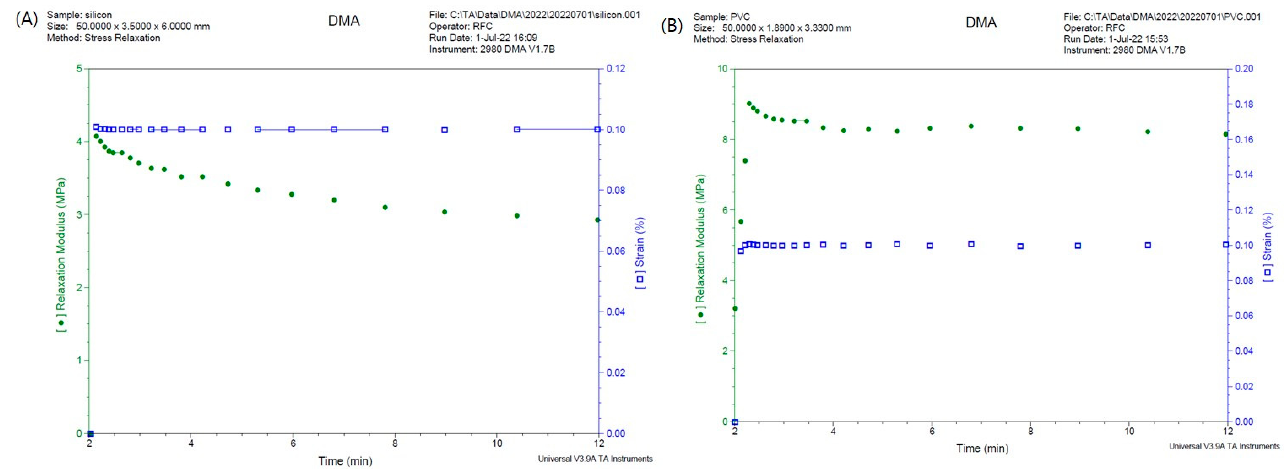
Figure 3. Stress relaxation test results using the CMA 2980 Dynamic Mechanical Analyzer: ( A ) Nasogastric tube. ( B ) Suction catheter.